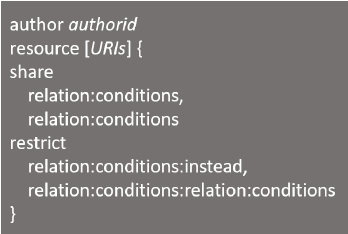
Figure 3. High-level grammar for multi-owner data